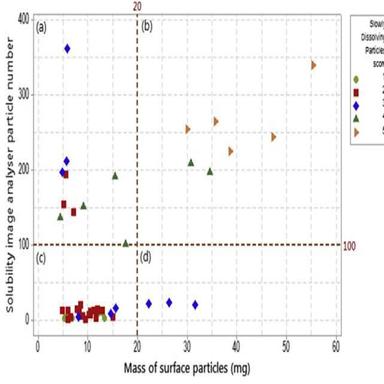
Plot of image analysis result (particle number) versus surface defects results (mass of surface particles). SDP scores are: , 1; , 2; , 3; , 4; , 5. Quadrants are: A, fails on particle number; B, fails on particle number, fails on surface defects; C, passes on particle number, passes on surface defects; D, fails on surface defects.